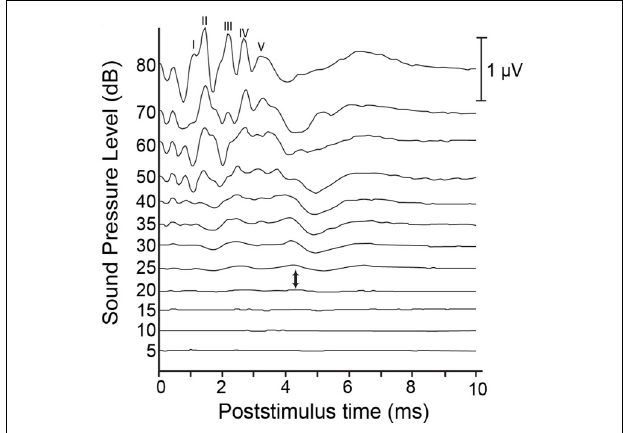
FIGURE 1 | Sample auditory brainstem responses (ABR) from a hearing cat. Auditory clicks are presented at levels ranging from 80dB down to 5dB SPL. Responses represent the average of 1000 presentations, and are comprised of 5 peaks: wave I is thought to be generated by the peripheral auditory nerve; wave II by the central auditory nerve; wave III by the cochlear nucleus; wave IV by the superior olive and lateral lemniscus; and wave V by the lateral lemniscus and inferior colliculus. Each of these characteristic peaks shows a reduction in amplitude and an increase in latency as presentation level decreases. Auditory thresholds are typically considered to lie somewhere between the presentation level at which no discernible response is present and the level at which a response is first elicited (between 20 and 25dB, respectively, in this